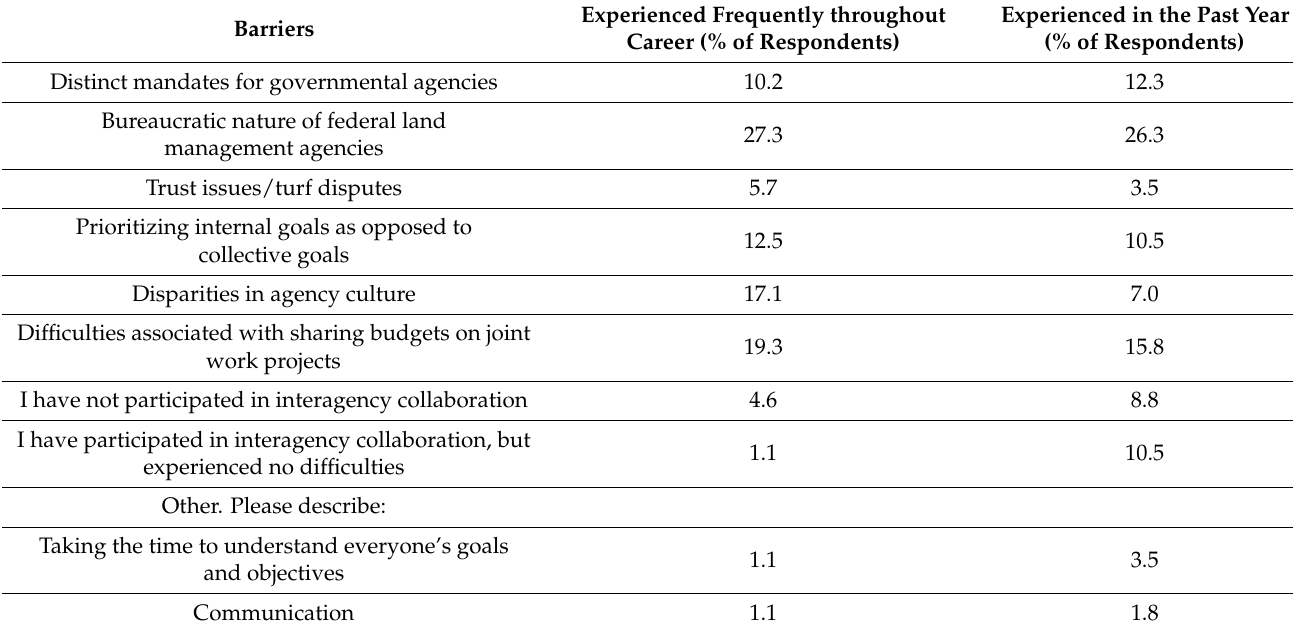
Table 3. Survey respondents identified barriers to interagency collaboration, distinguishing between those experienced in the past year and those experienced most frequently over the course of their